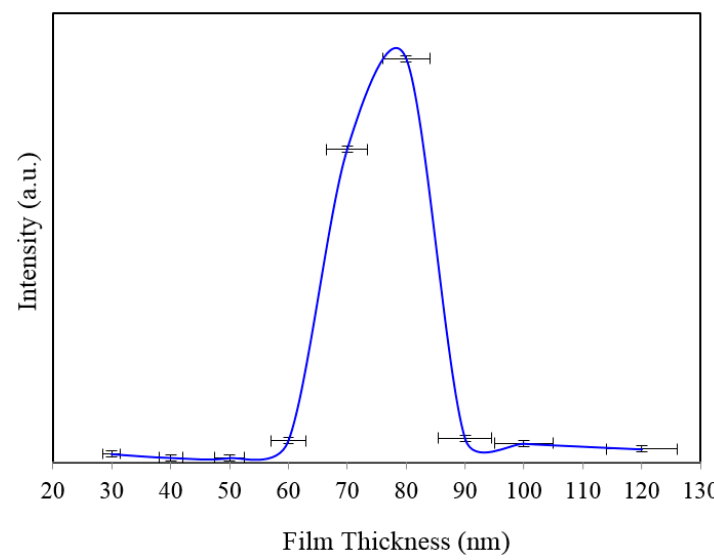
Figure 3. Peak SERS intensities measured at about 1361 cm − 1 measured from 8 × 10 − 5 M solution of Rh6G dye adsorbed on the surface of 30, 40, 50, 60, 70, 80, 90, 100 and 120 nm gold films deposited on 35 nm nanoporous SERS substrate with 3 s integration time.